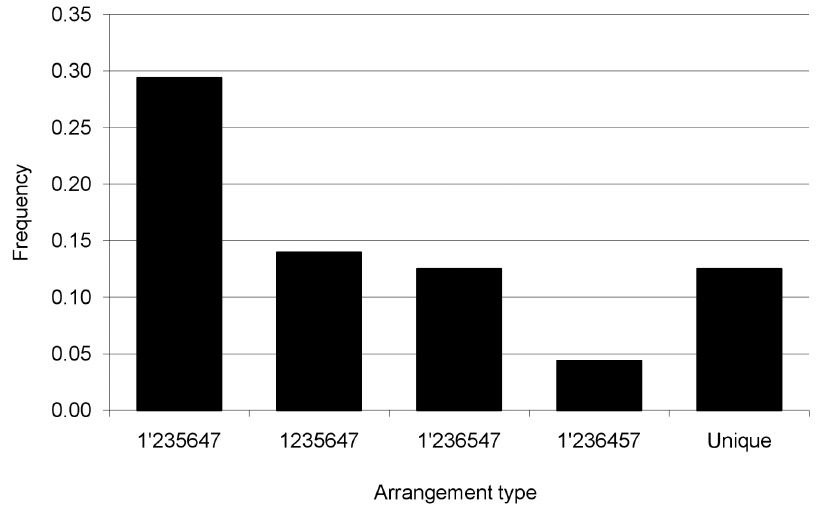
Figure 2. Frequency of most common and unique arrangement types in of Salmonellaenterica sv. Typhi. Data compiled from 136 Typhi strains previously characterized [44]. 1 9 indicates that region 1 is in the inverted orientation. In the two most common arrangement types, Region 4 translocated in between Region 6 and Region 7. The two other common arrangement types had an interreplichore translocation of Region 6 next to Region 3. Except for arrangement types that are unique (only found in one strain), the frequencies of other less common arrangement types are not shown.